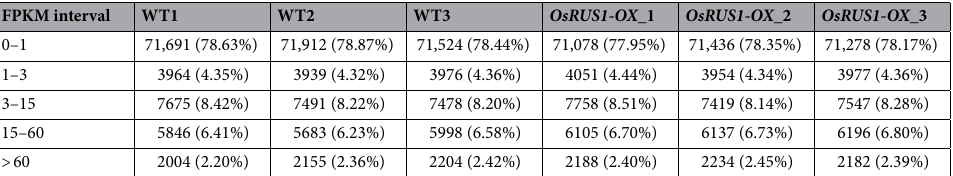
(Table 2). According to the FPKM distribution and FPKM density distribution data between WT and OsRUS1- OX , only a small number of genes had altered expression patterns (Supplementary Figure S6). The differentially expressed genes identified between WT and OsRUS1-OX . The molecular basis of the dynamic leaf rolling phenotype of OsRUS1-OX may be facilitated by the genes that are differentially expressed between WT and OsRUS1-OX . In our experiments, there were a total of 2920 differentially expressed genes identified, of which 1660 were upregulated and 1260 were downregulated (Supplementary Table S3). A hierarchical clustering of the differentially expressed genes was made according to the log 10 (FPKM + 1) values of the two samples (Fig. 3). In this analysis, we observed that the number and fold change level of upregulated genes exceeded that of downregulated genes. The relative expression levels (log 2 (ratios)) of the differentially expressed genes were analyzed by a cluster analysis based on the K-means method 29 . Eight expression clusters of differentially expressed genes were identi- fied (Fig. 4). The most abundant group was subcluster 5, with 1241 genes that showed a positive slope and were expressed at the highest levels in OsRUS1-OX . The upregulation amplitudes of the relative expression levels of genes in subcluster 1 were larger than those in subcluster 3 and subcluster 5. The second most abundant group was subcluster 7, with 769 genes that showed a negative slope and were downregulated in OsRUS1-OX . Subcluster 2, subcluster 4, subcluster 6 and subcluster 8 showed a similar pattern with subcluster 7, but the downregulated amplitudes of the relative expression levels of genes in subcluster 2 were the largest. levels (see Supplementary Table S4 for the gene list for each category). From the patterns of gene expression, we predicted that the upregulation and downregulation of some genes might be the cause of the rapid and dynamic